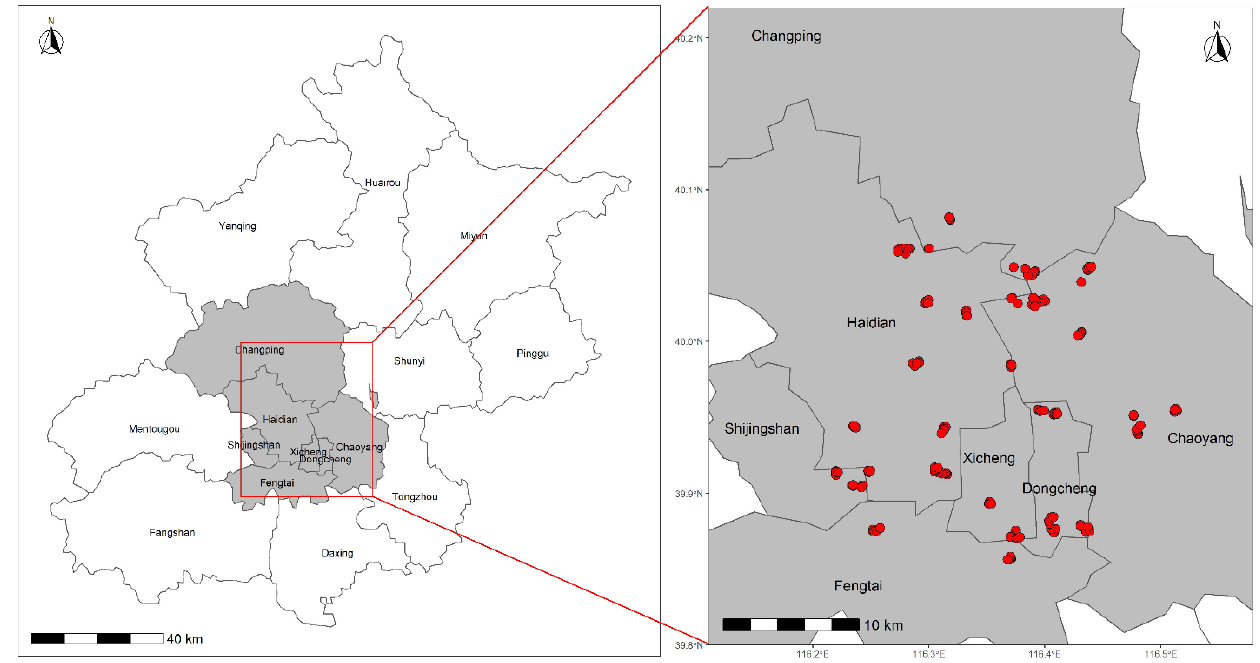
Figure 1. Locations of the sample plots in Beijing, China: regions of study shown in grey, magnifi- cation to show the sampling sites as red dots.